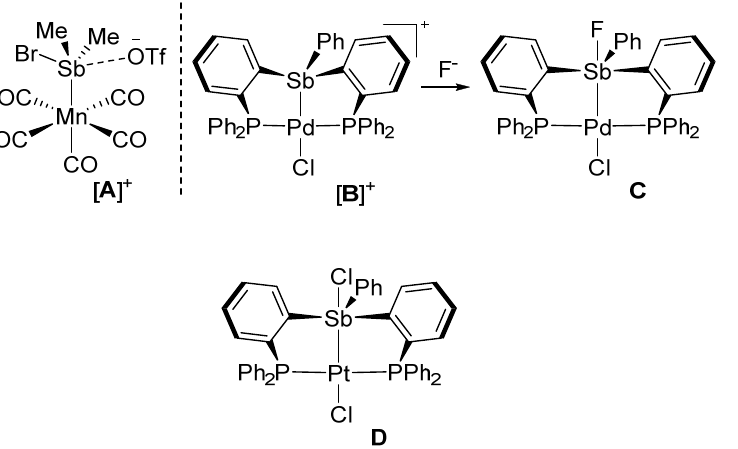
Figure 1. Structure of representative stibine complexes in which the antimony atom displays Lewis acidic properties.